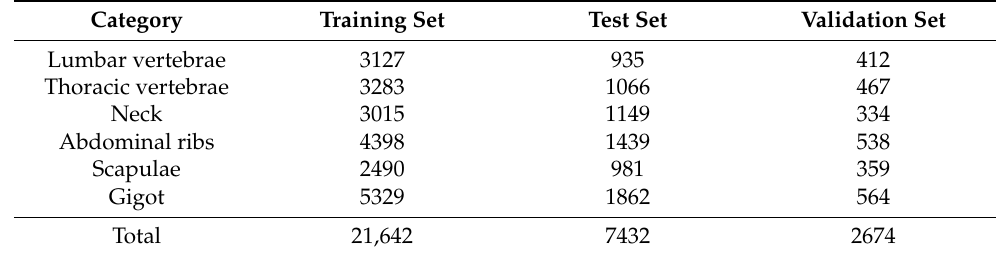
Table 1. Distribution of the number of different types of parts in the mutton multi-part images da- taset.